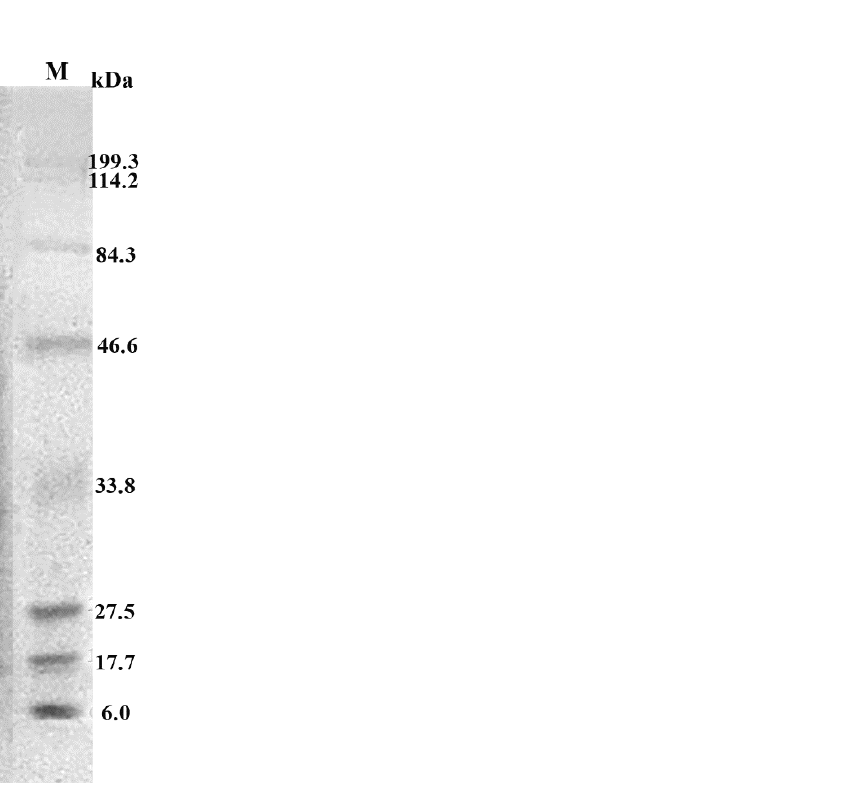
Figure 1. SDS-PAGE. Single dimensional gel electrophoresis of extracellular proteins of S. pasteuri isolated from estrus CM. kDa on the right denotes the standard protein molecular weight (MW) marker. kDa on the left shows the approximate MW of high intensity proteins from S. pasteuri. The original figure is provided in the supplementary file S1 Figure S2 from which lane 5 and the marker lane are used here as the major figure for a better understanding of the exoproteome.